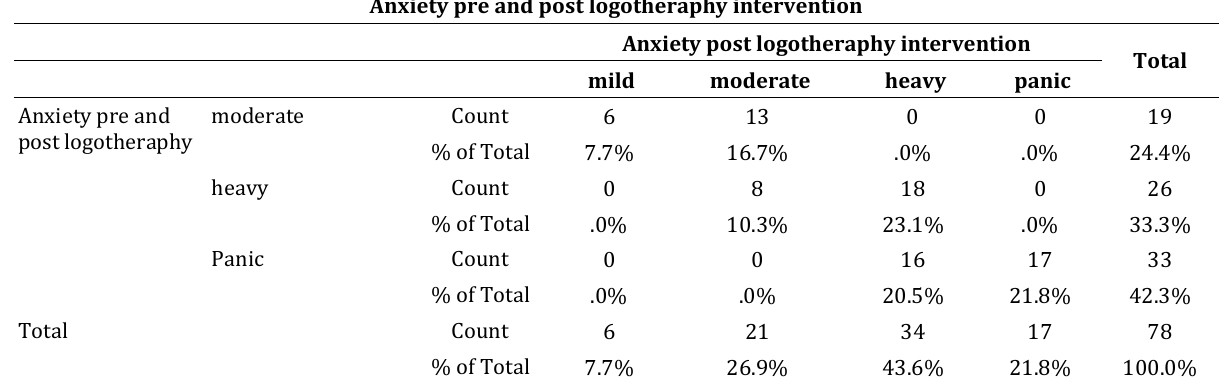
Table 4. Cross tabulation of prisoners' anxiety before and after a paradoxical intention logotherapy session 1 at the Penitentiary Class II A of the City of Kediri